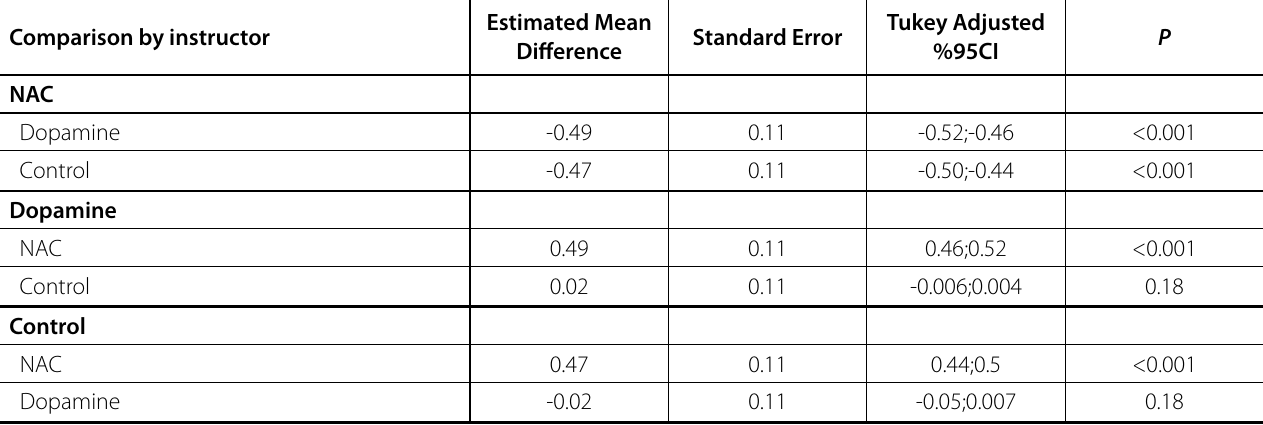
Table 7 . Postoperative day 1. Post-hoc evaluation of creatinine with Tukey HSD.